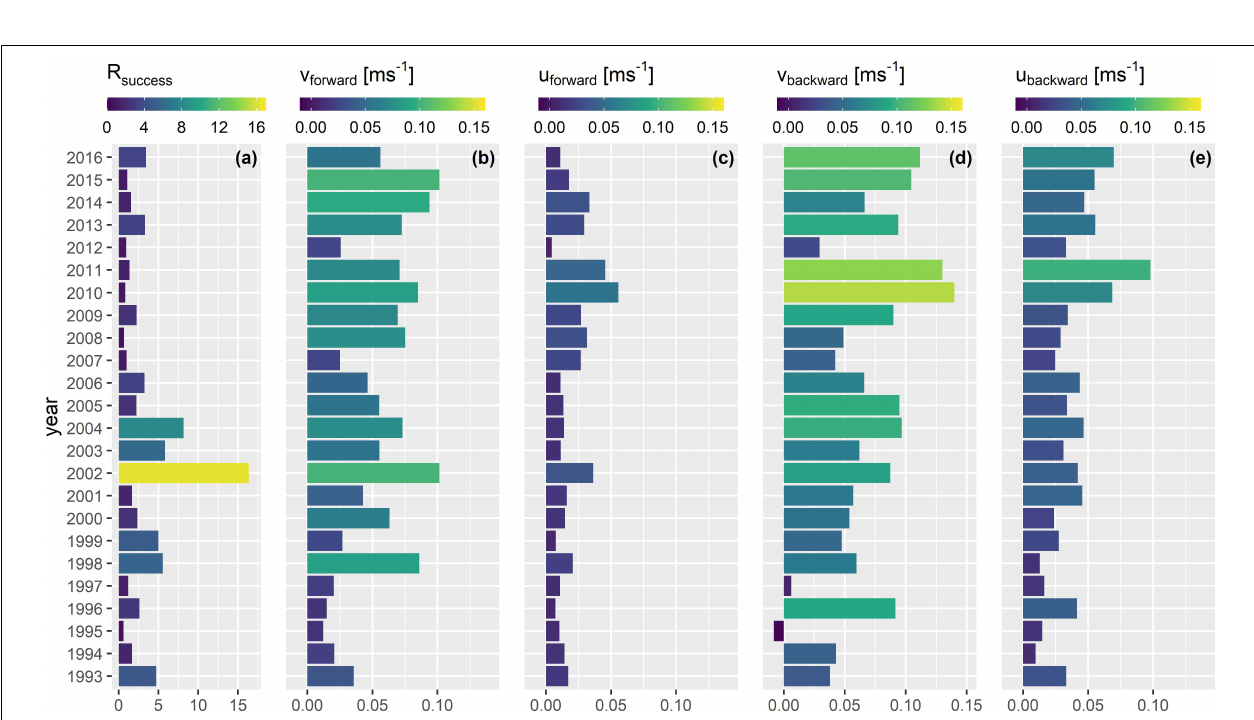
FIGURE 4 | Annual index for (a) R success (R age 2 /SSB t − 2 ), and annual mean indices of larval drift for (b) v forward , (c) u forward , (d) v backward , and (e) u backward .